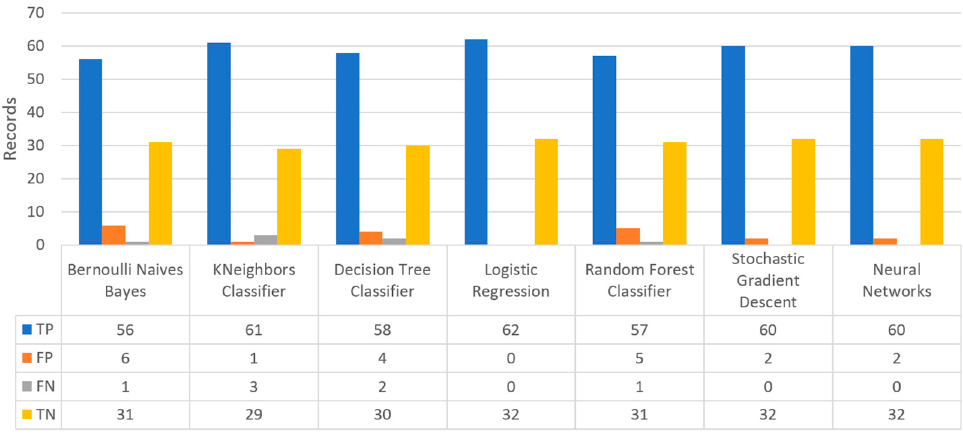
Figure 28. Confusion matrix of prediction results for breast cancer use case.